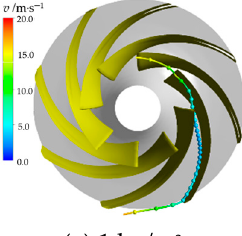
Figure 18. Distribution of solid volume fraction under different particle concentrations. 3.3.2. Effect of Particle Concentration on Erosion Characteristics Figure 19 shows the distribution of single blade erosion rate with different particle concentrations. It can be seen from Figure 19 that the erosion rate of leading edge and trailing edge increases with the increase in particle concentration under the same particle size and different particle concentration, and the erosion morphology is the same. It can be seen that the change in particle concentration basically does not change the erosion morphology and erosion position— it only changes the erosion range and erosion rate on the original position, which is consistent with the particle motion trajectory, that is, the particle concentration has little effect on the erosion morphology and erosion position. ( a ) 1 kg/m 3